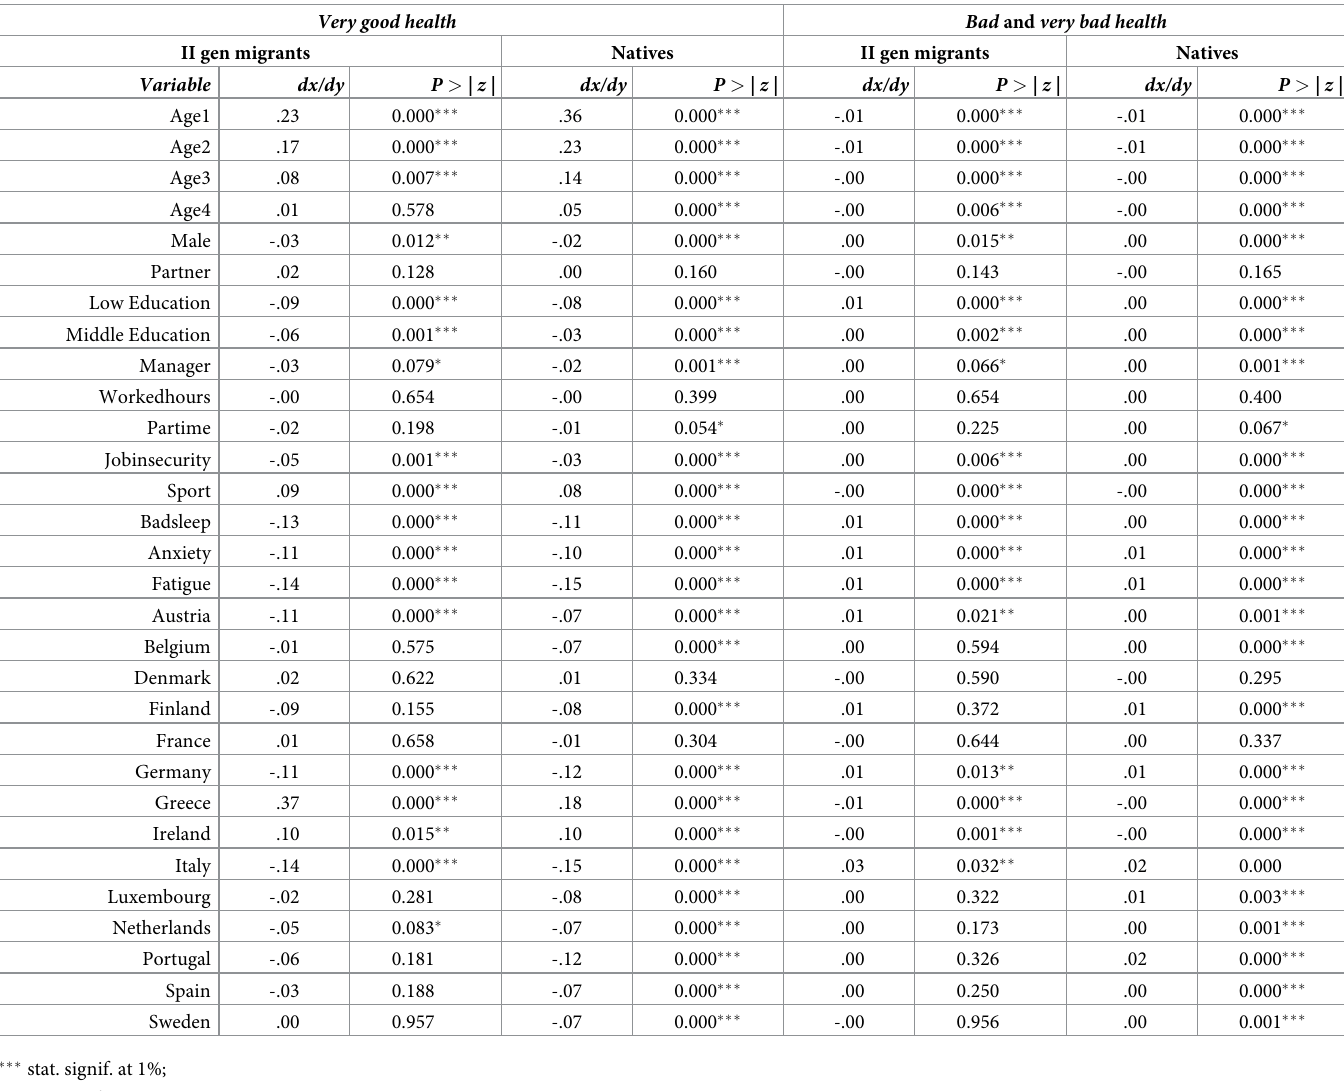
Table 4. Marginal effects. SRH as four values variable, one (very good) four (bad and very bad) . Very good health Bad and very bad